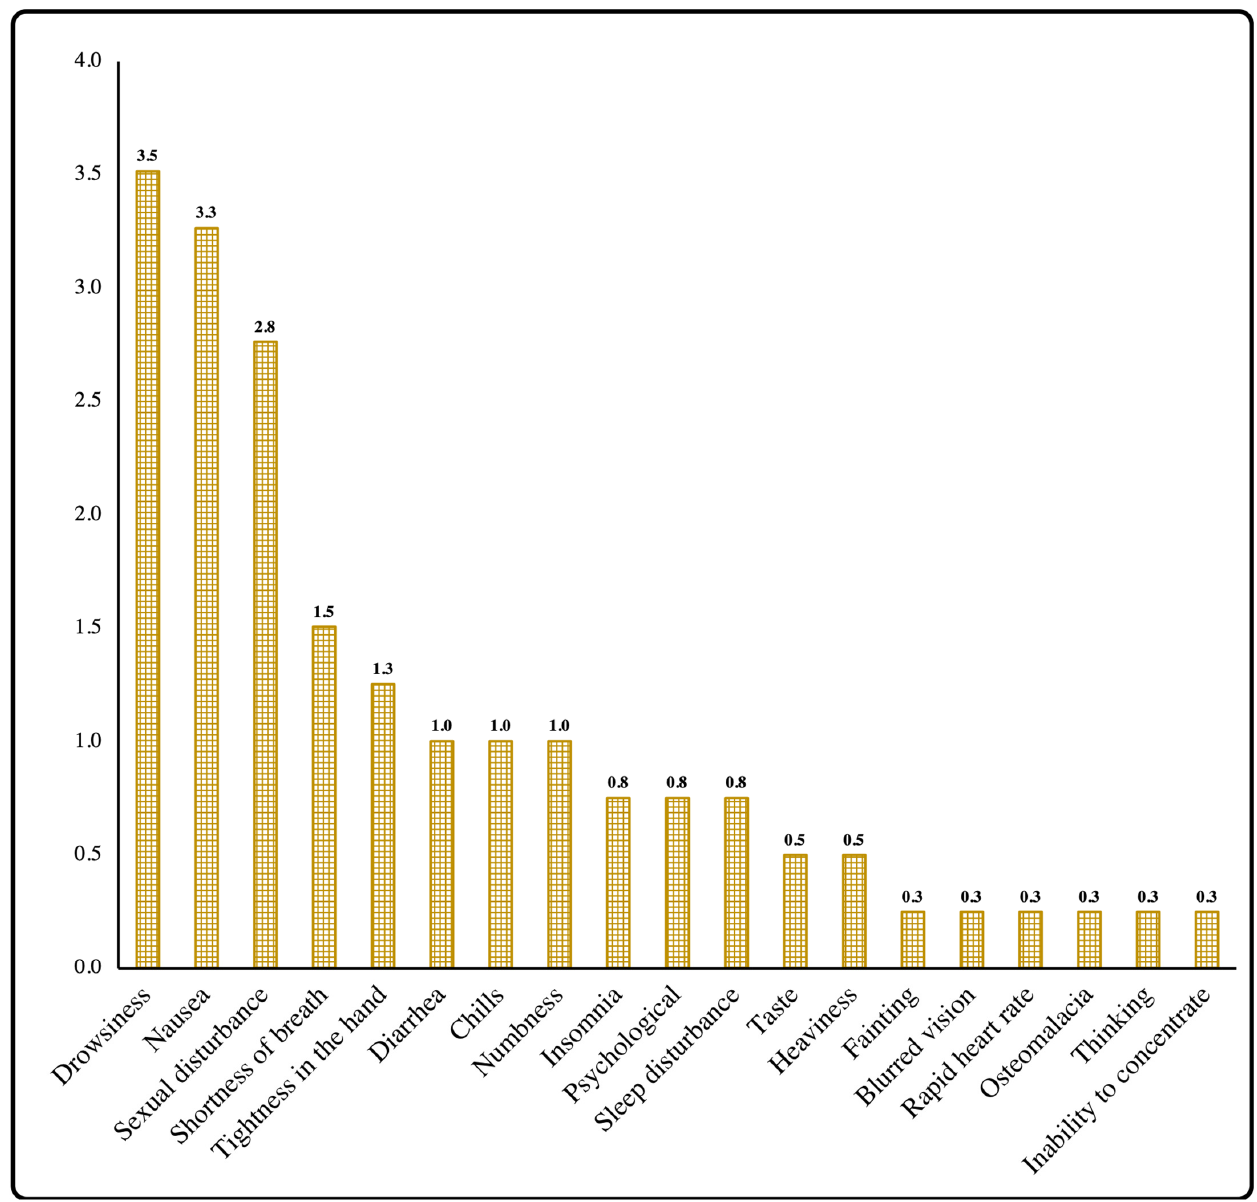
Figure 3. Percentage of rare side effects among study participants. Table 2. Mean side effect score among demographics (N =